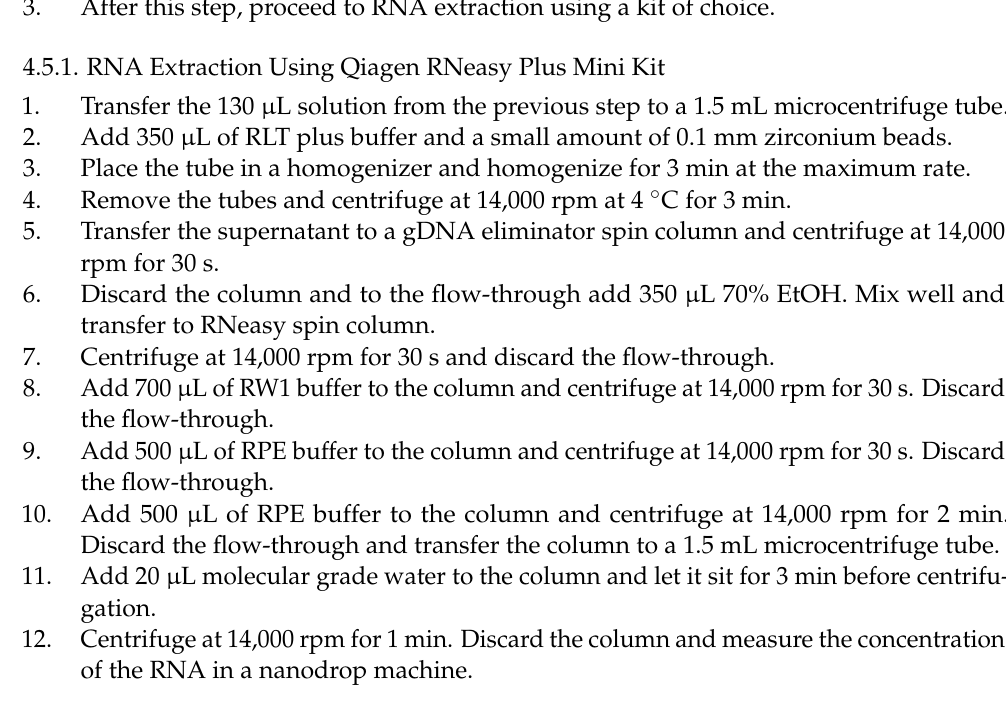
Table 2. Settings for the PALMRobo 4.8 pro software for the dissection of butterfly larval and pupal wing